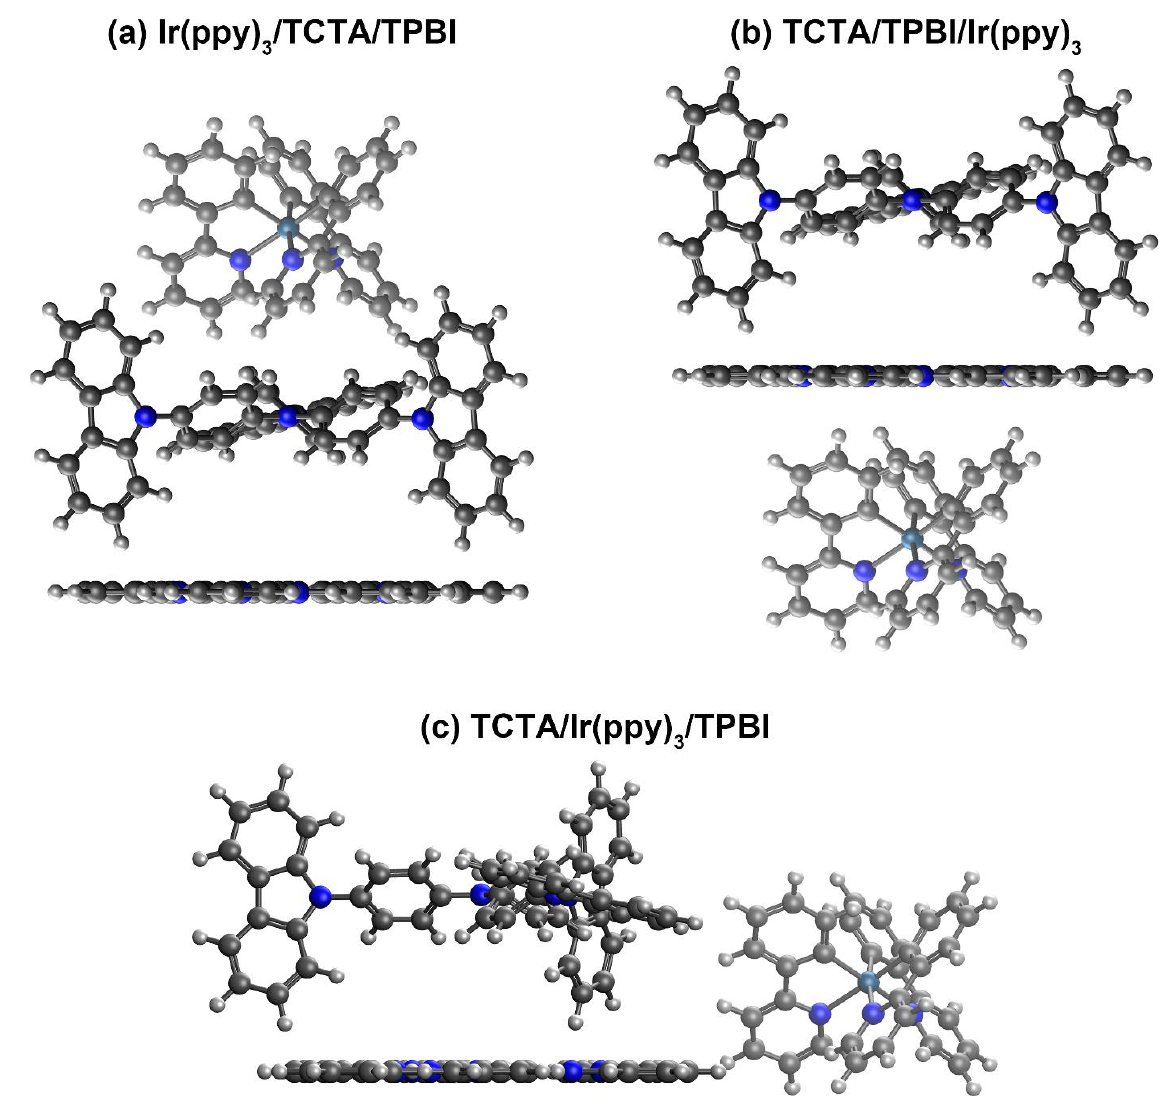
Figure 4. Illustrations of trimer model systems. For ease of distinction, Ir(ppy) 3 is shown in lighter colors.